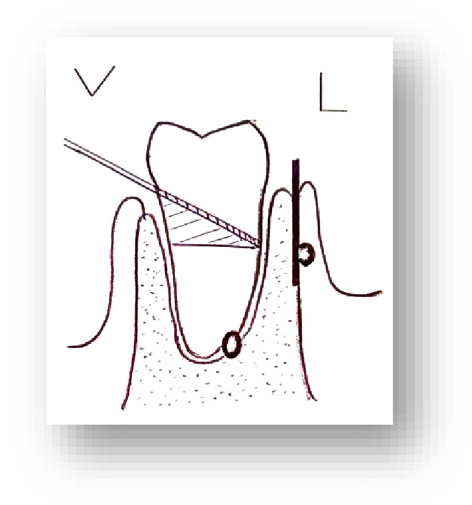
Fig. 4. Drawing of crown separation and enamel